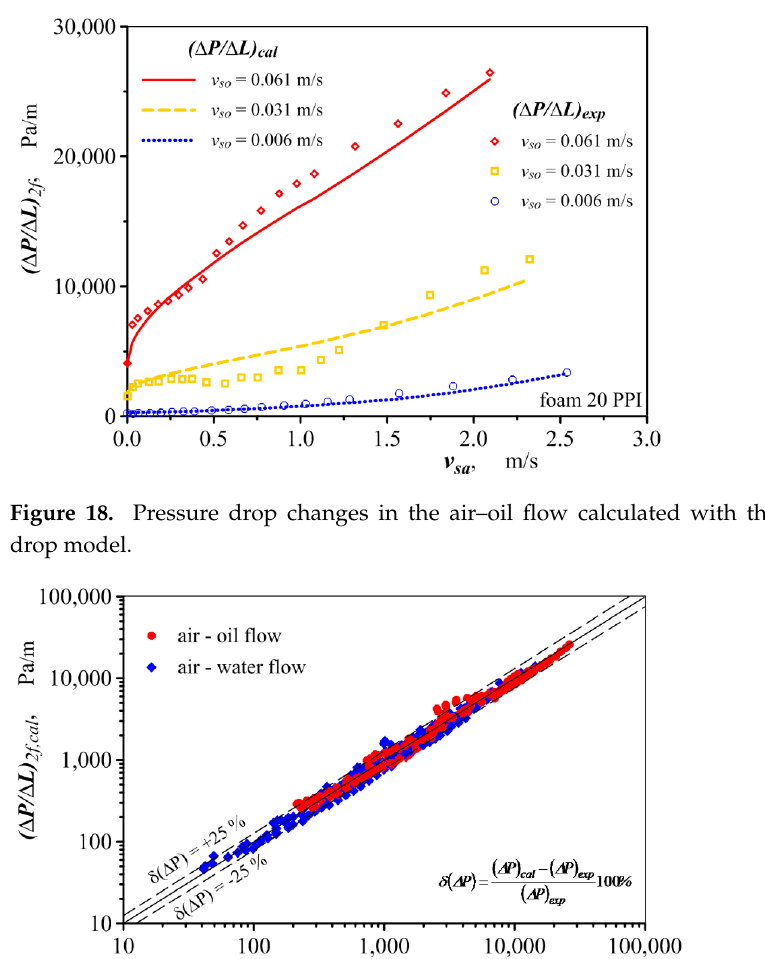
Figure 17. Pressure drop changes in the air–water flow calculated with the developed pressure drop model.